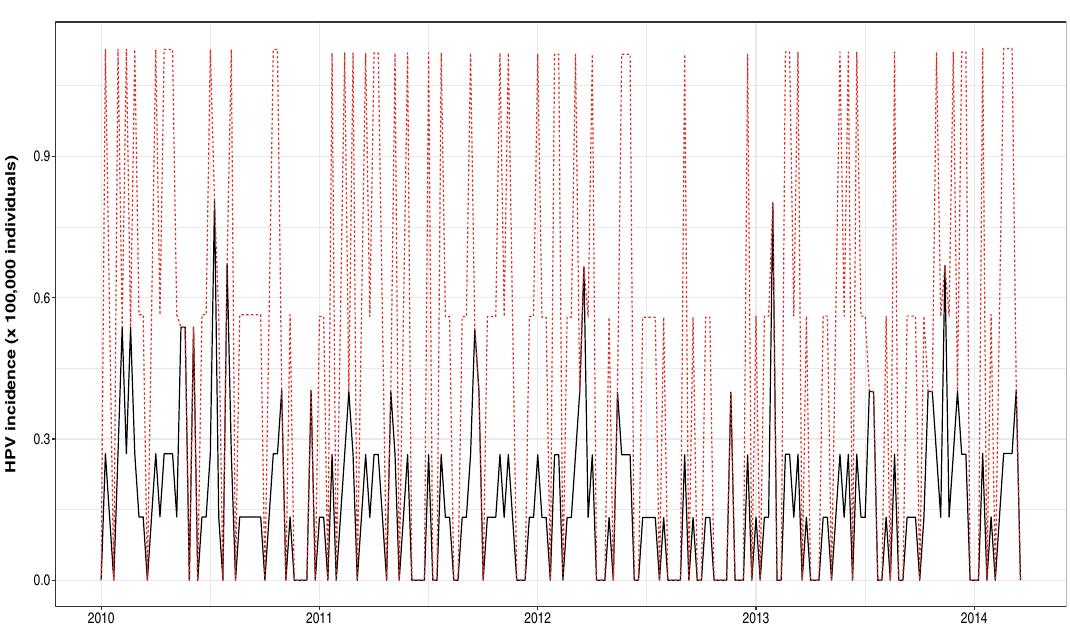
Figure 2. Registered (black solid line) and estimated (red dotted line) HPV incidence in Girona in the period